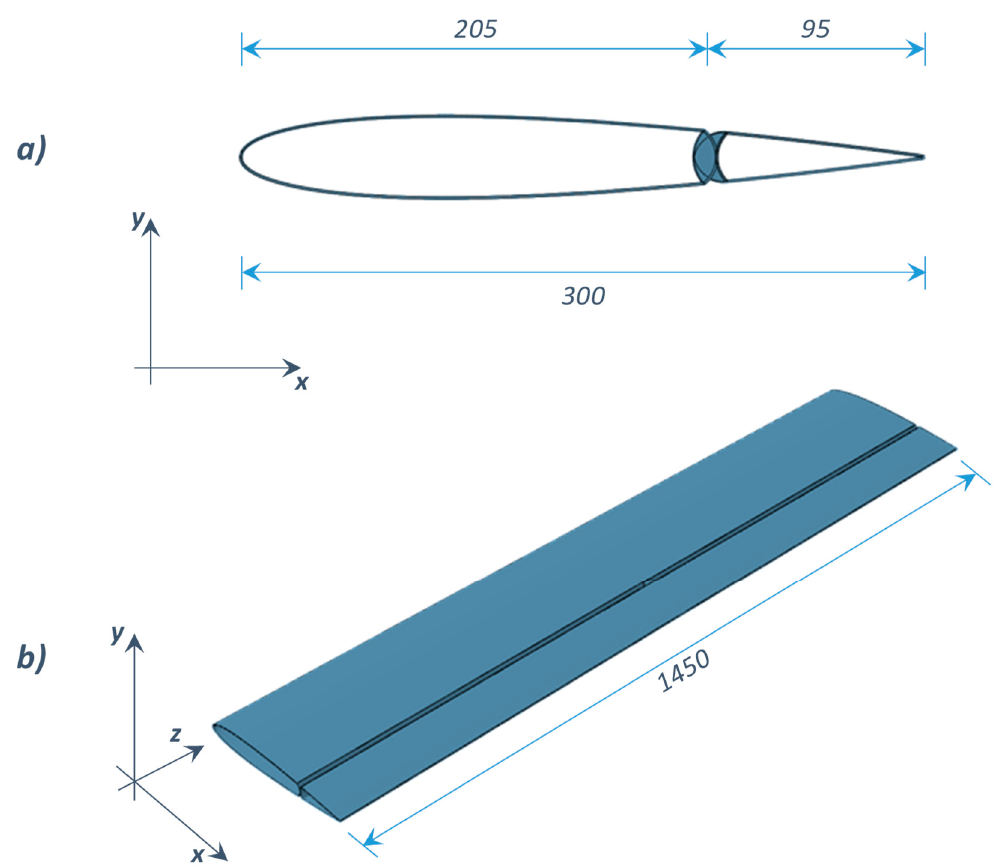
Figure 3. Spoiler and actuated elevator: ( a ) cross section; ( b ) isometric view. (unit: mm)